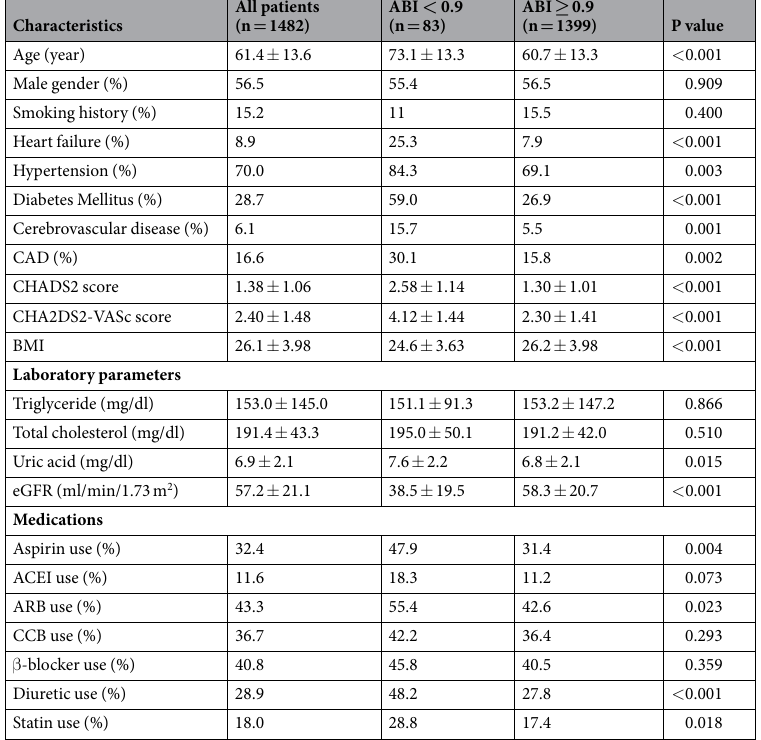
Table 1. Comparison of clinical characteristics between patients with ABI < 0.9 and ≥ 0.9.